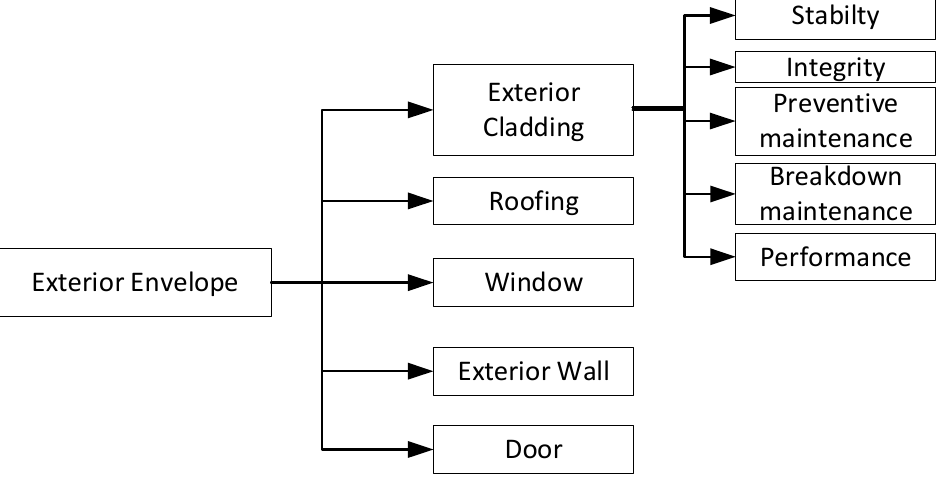
Figure 2. Structure of object classes for parameters of the integrated safety–maintenance in the user ‐ Interface.